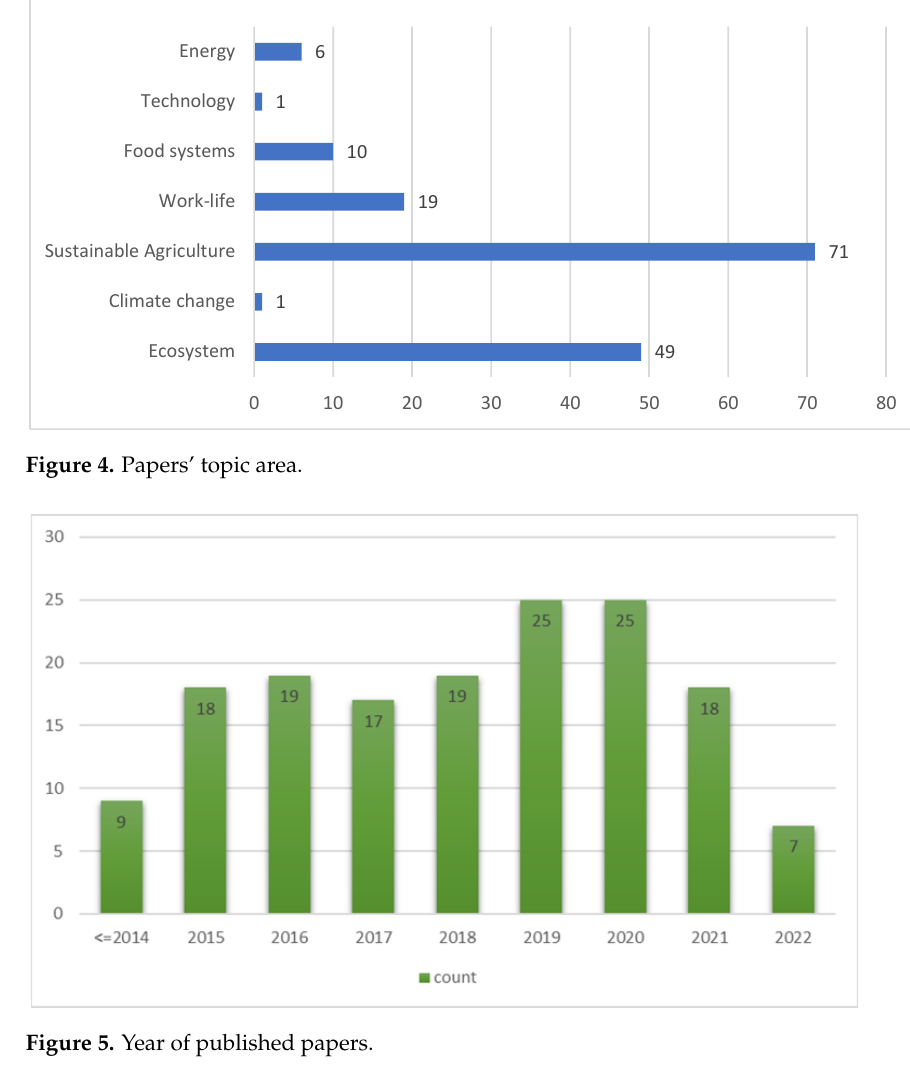
Figure 5 . Year of published papers .